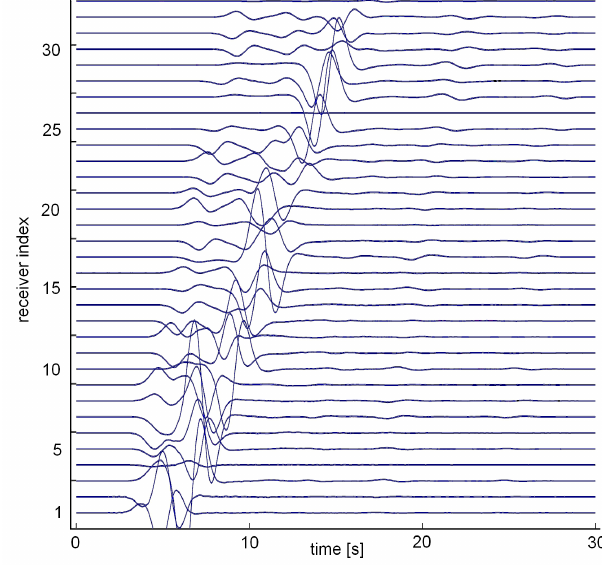
Fig. 2. N–S-component synthetic seismograms recorded at the 33 stations for a moment tensor point source with only M xy 6= 0. The stations are sorted by distance to the epicentre and the traces are scaled to the maximum